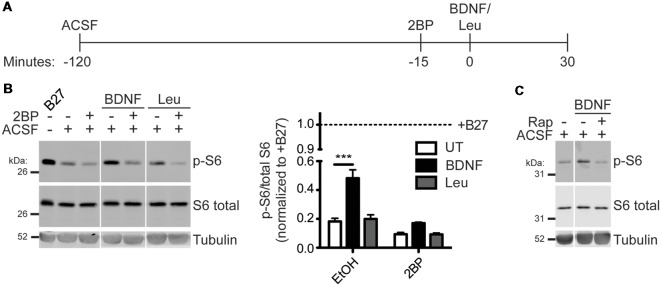
Brain-derived neurotrophic factor (BDNF) activation of mTORC1 in hippocampal neurons is palmitoylation-dependent. (A) Scheme of the BDNF stimulation paradigm. DIV14–16 primary rat hippocampal neurons were placed in artificial cerebrospinal fluid (ACSF) for 2 h before stimulation with 100 ng/mL BDNF or 5 mM Leu. Fifteen minutes prior to stimulation, cells were treated with ethanol (EtOH) or 50 μM 2BP to inhibit palmitoylation. Neurons were stimulated for 30 min with BDNF or Leu. (B) Lysates were blotted to detect p-S6 (top), S6 total (middle), and tubulin (bottom) levels. Right panel histogram shows quantified data from multiple experiments, normalized to the regular growth media with B27 (+B27) condition [two-way ANOVA: 2BP p < 0.0001 (F(2) = 28.41), treatment p < 0.0001 (F(1) = 59.31), interaction p = 0.0017 (F(2) = 9.52); N = 3–5; Bonferroni post hoc test ***p < 0.001]. Panels are composites of the same Western blot image. (C) Neurons were stimulated as in B with BDNF, but 15 min prior to stimulation cells were treated with EtOH or 100 nM rapamycin (Rap) to inhibit mTOR.